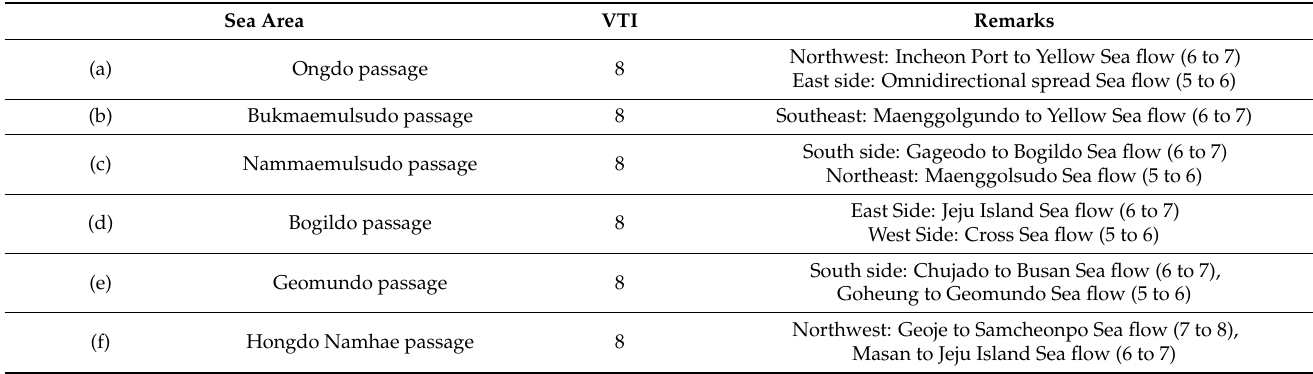
Table 9. Comparison of utilization status by sea area according to VTI.